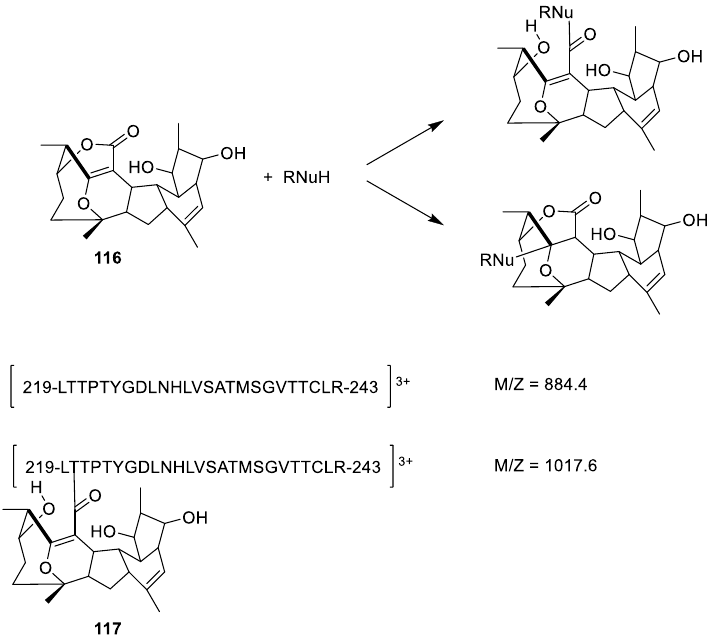
Figure 31. Possible paths for reacting cyclostreptin ( 116 ) with microtubules. Either the lactone